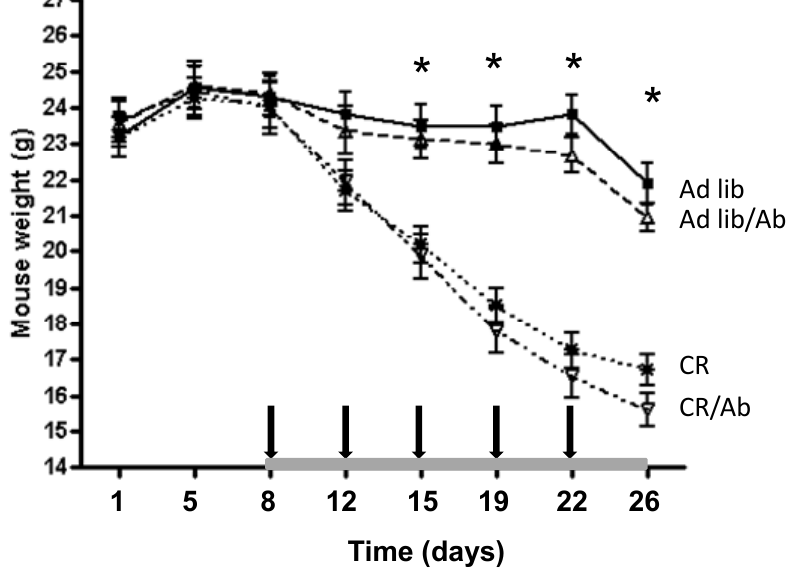
Figure 1. SCID mouse weights. Mice were weighed twice weekly from the day of 22Rv1 cells injection (day 1). Values are expressed as mean ± standard errors (SE). The gray bar on the x axis indicates the length of the diet intervention. The arrows indicate the time of saline or ganitumab injections. * indicates significant differences in body weight between mice from Ad-lib groups and the CR groups, p <